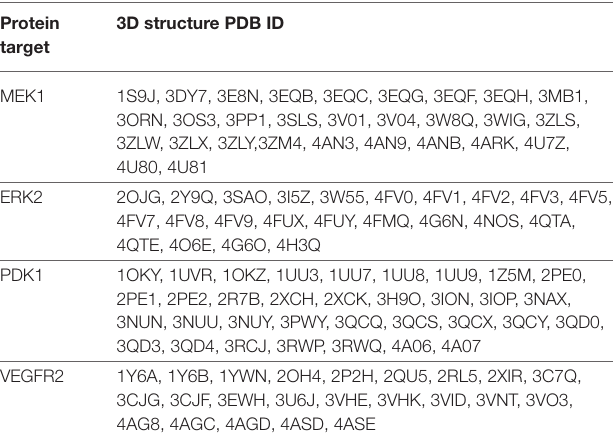
TABLE 1 | PDB ID’s of the selected 3D protein structures used as targets for virtual screening. Protein